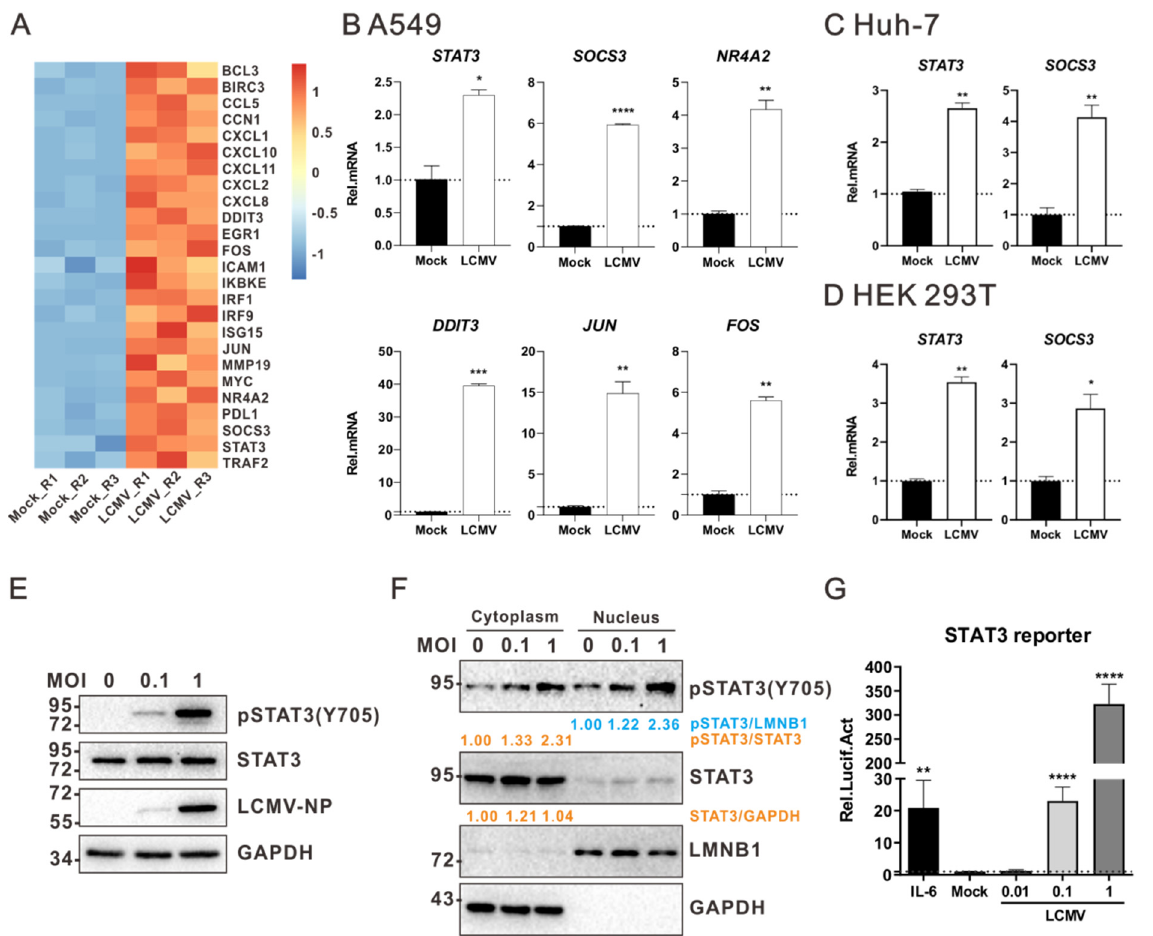
Figure 1. LCMV infection activates STAT3 signaling pathway. ( A ) Transcriptomic analysis of LCMV-infected A549 cells. A549 cells were infected with LCMV at an MOI of 0.01 or mock-treated. Thirty-six hours later, the cells were collected. Total mRNA was extracted and subjected to RNA-seq sequencing. ( B – D ) LCMV infection induces the transcription of STAT3 and its target genes on A549 ( B ), Huh-7 ( C ), or HEK 293T ( D ) cells. A549 and Huh-7 cells were infected with LCMV at an MOI of 0.01. HEK 293T cells were infected with LCMV at an MOI of 1. At 24 h p.i., cells were collected for total RNA extraction and qRT-PCR experiments. GAPDH mRNA levels were used as an endogenous control. ( E ) LCMV infection activates the phosphorylation of STAT3 Y705. HEK 293T cells were infected with LCMV at the indicated MOIs. At 24 h p.i., cells were lysed for Western blot analysis. ( F ) LCMV infection promotes the nuclear translocation of pSTAT3 (Y705). HEK 293T cells were infected with LCMV. At 24 h p.i., cells were collected and then fractionated into nuclear and cytoplasmic fractions for Western blot analysis. To normalize the STAT3 protein intensity, lamin B1 (LMNB1) and GAPDH were used as the nuclear and cytoplasmic endogenous controls, respectively. Relative protein intensity of pSTAT3 and STAT3 was analyzed using the ImageJ software. ( G ) LCMV infection activates STAT3 reporter activity. HEK 293T cells were transfected with the pSTAT3 reporter plasmid, and at 24 h post transfection, cells were infected with LCMV at the indicated MOIs. At 12 h post infection, cell was lysed and subjected to luciferase assays to measure the STAT3 reporter activity. IL-6 treatment was used as a positive control. A representative from at least three independent experiments is shown. Graphs show mean ±